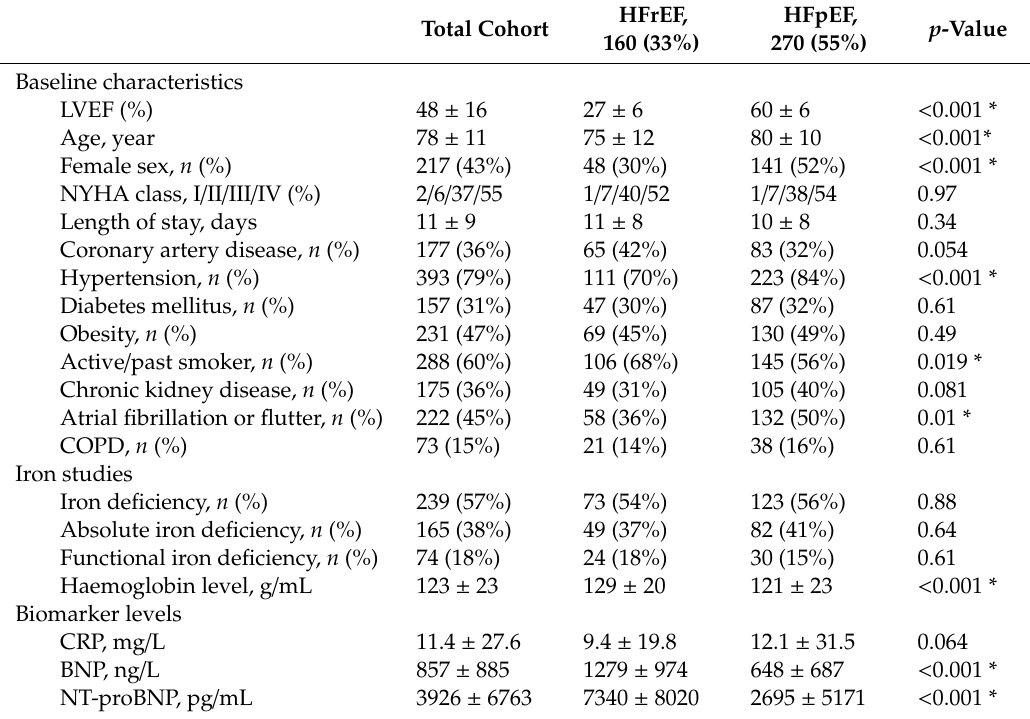
Table 1. Patient characteristics, iron status, biomarker levels, and diastolic function indices on transthoracic echocardiography (TTE), according to heart failure